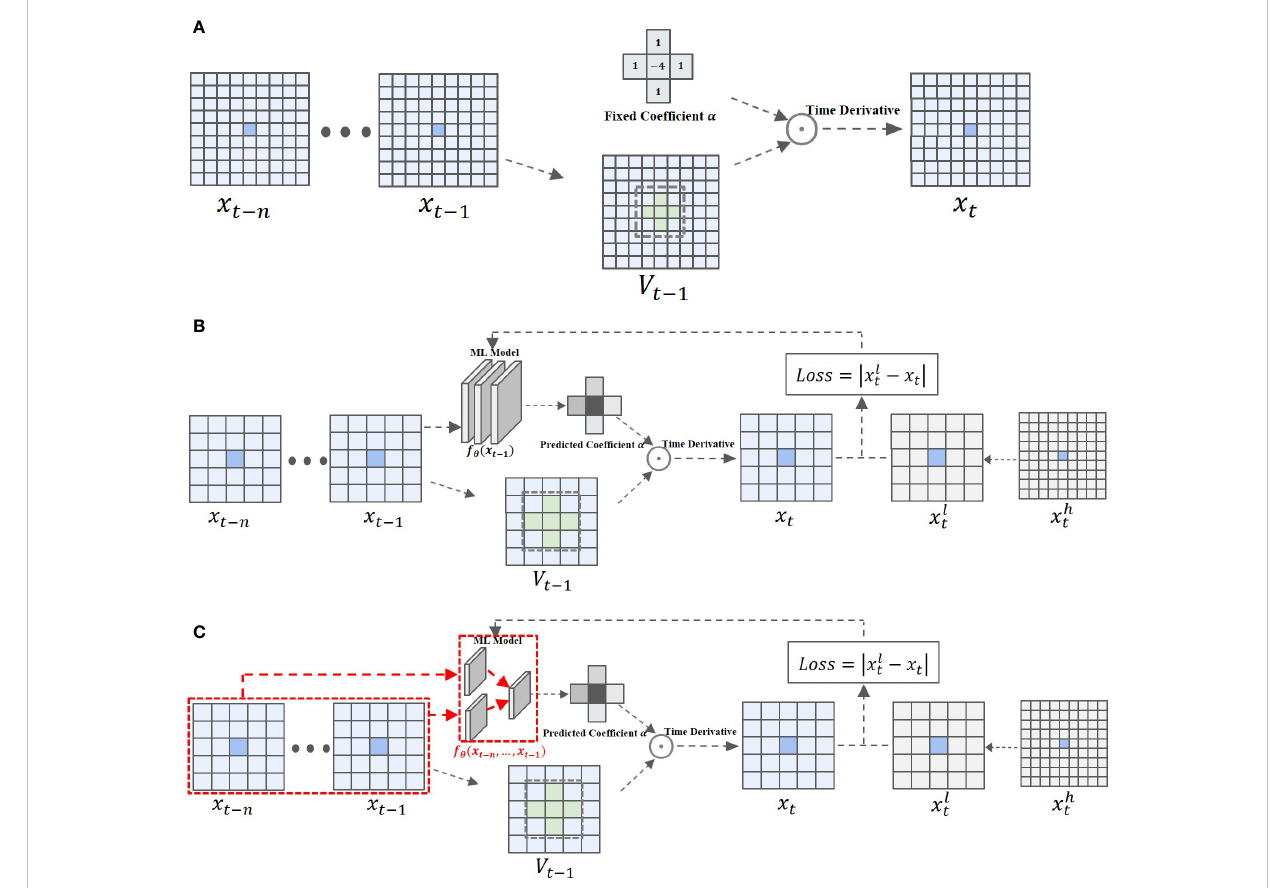
FIGURE 1 This fi gure shows three methods used to solve the spatial derivative during spatial discretization. (A) Figure 1(a) shows a traditional numerical method. (B) Figure 1(b) shows the deep-learning-based method. (C) Figure 1(c) shows our method. (A) The traditional numerical method: in the spatial discretization part, the central difference method is used to calculate the spatial derivative with a fi xed spatial discretization coef fi cient, and then the temporal derivative is calculated in the temporal discretization process to obtain the numerical solution. (B) The Deep-learning-based method: In the spatial discretization part, predict the spatial discretization coef fi cient and calculate the spatial derivative based on the deep learning algorithm and the grid value at time t-1, and then calculate the temporal derivative in the temporal discretization process to obtain a numerical solution. (C) . Our method: In the spatial discretization part, predict the spatial discretization coef fi cient and calculate the spatial derivative based on the deep learning algorithm and the grid value of the time series {t − n, … , t − 1}, and then calculate the time derivative in the time discretization process to obtain a numerical